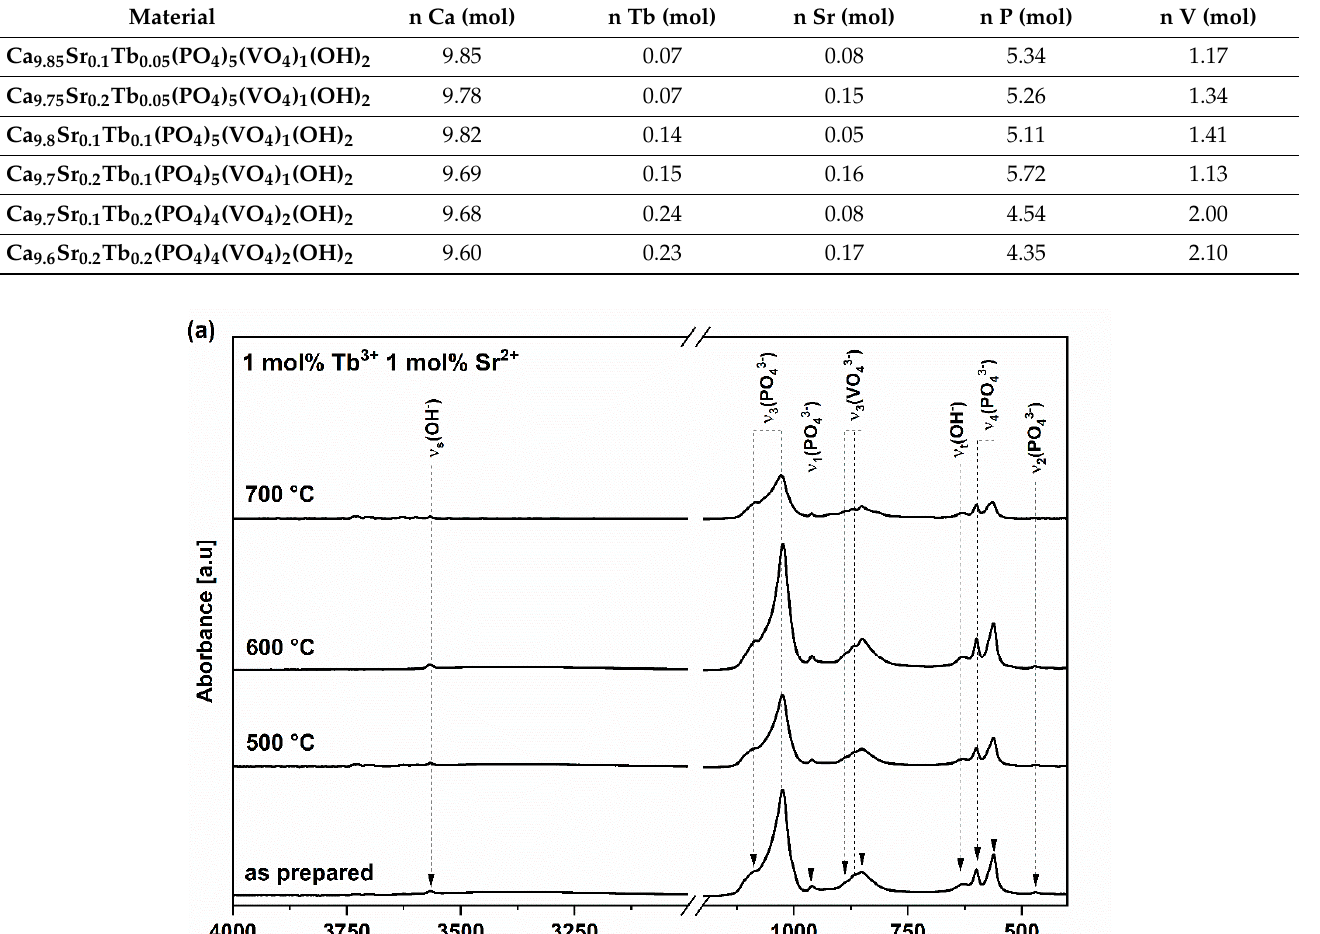
Table 1. The elemental contents in the obtained materials (annealed at 600 ◦ C) measured with the ICP-OES technique.